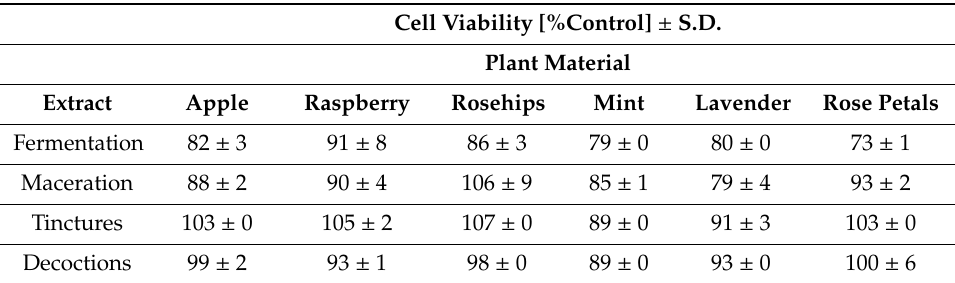
Table 5. Viability of lymphocytes exposed to plant extracts for 1 h at 37 ◦ C. Cell Viability [%Control] ± S.D.